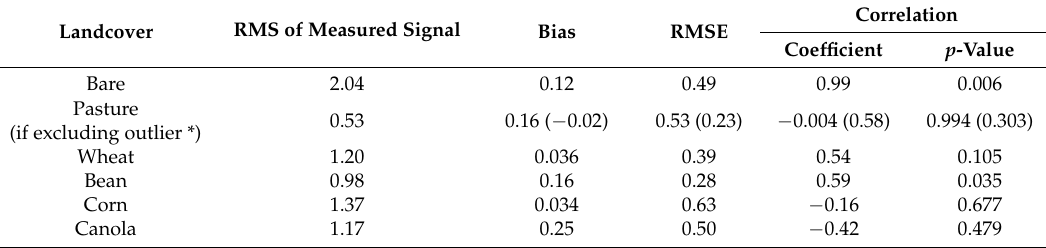
Table 2. Evaluation statistics of surface roughness retrieval in cm, shown in Figure 3. (*) the outlier is the result of automated unsupervised estimate and is correctable through supervision. p -value [0, 1] quantifies a probability of occurrence of the null hypothesis that the correlation results from random